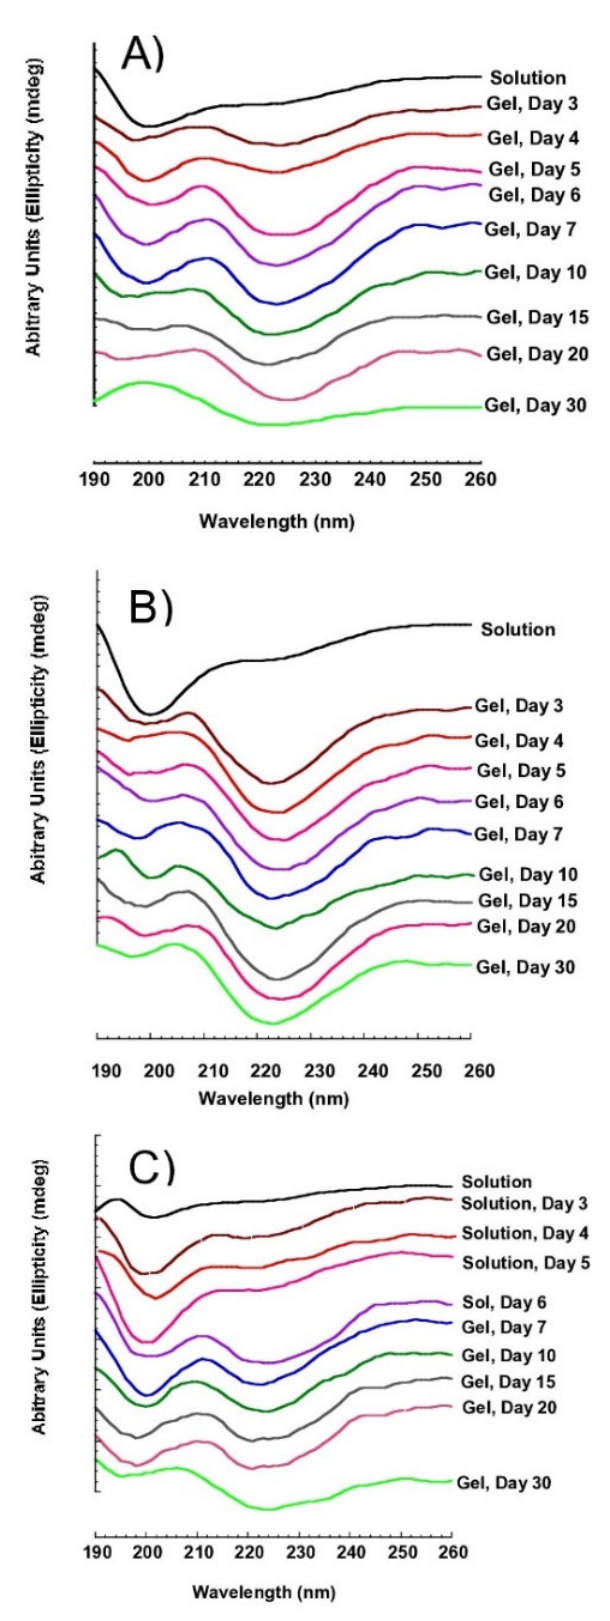
Figure 6. CD spectrum of SS Gel at 4 °C. ( A ) Water SS extract, ( B ) EtOH 5% SS extract, and ( C ) glycine 5% SS extract.